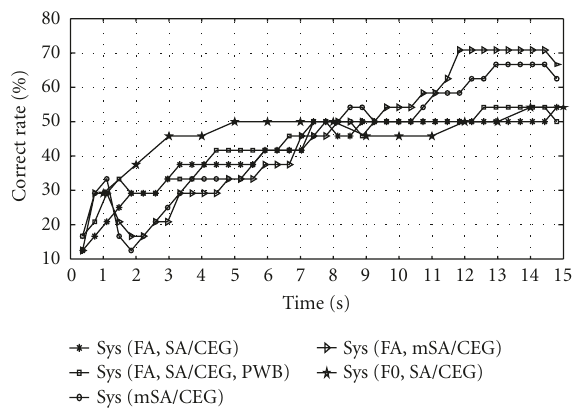
Figure 9: Correct rate of five extended systems on Chopin’s 24 Pre- ludes.